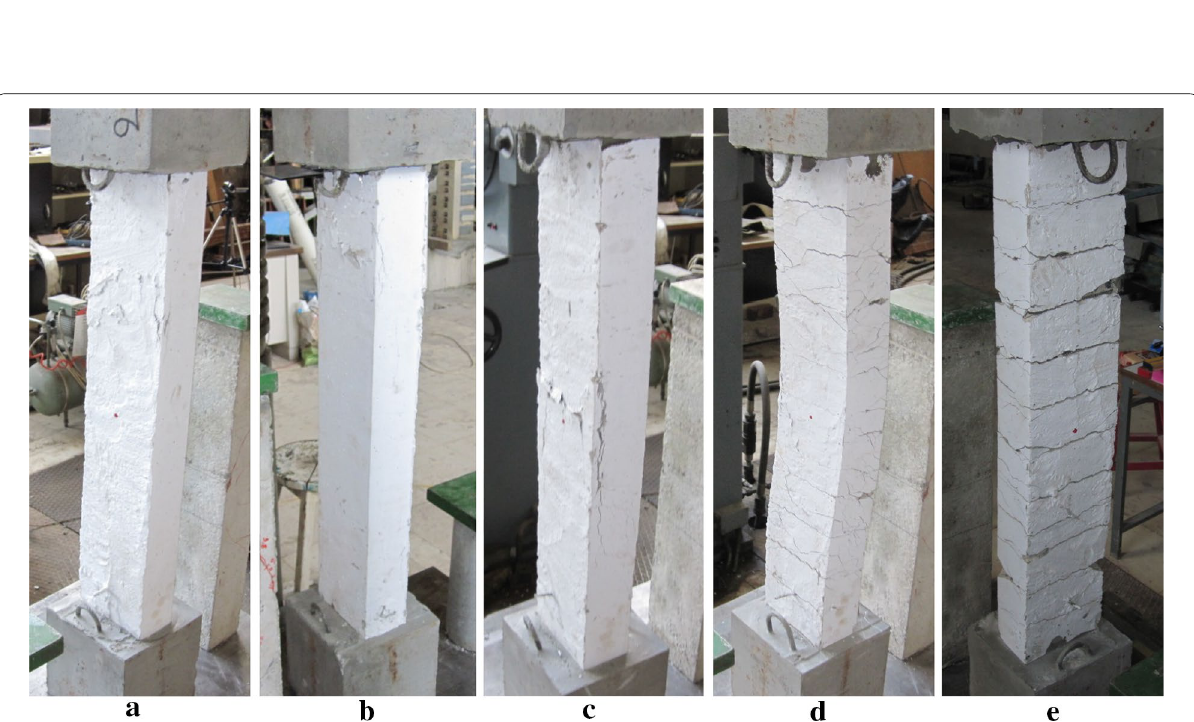
Fig. 5 Failure modes after the conduct of the compression experiment: a C-0, b C-10, c C-20, d C-30, e